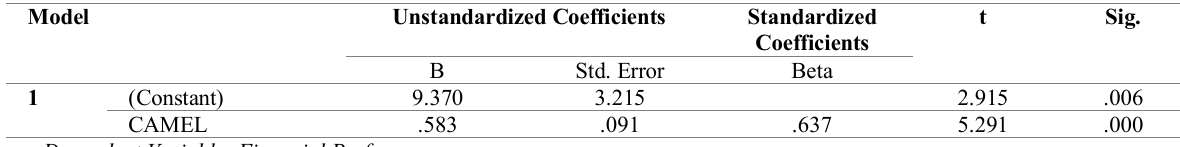
Table 9: Regression Coefficients for Bank Stability and Financial Performance